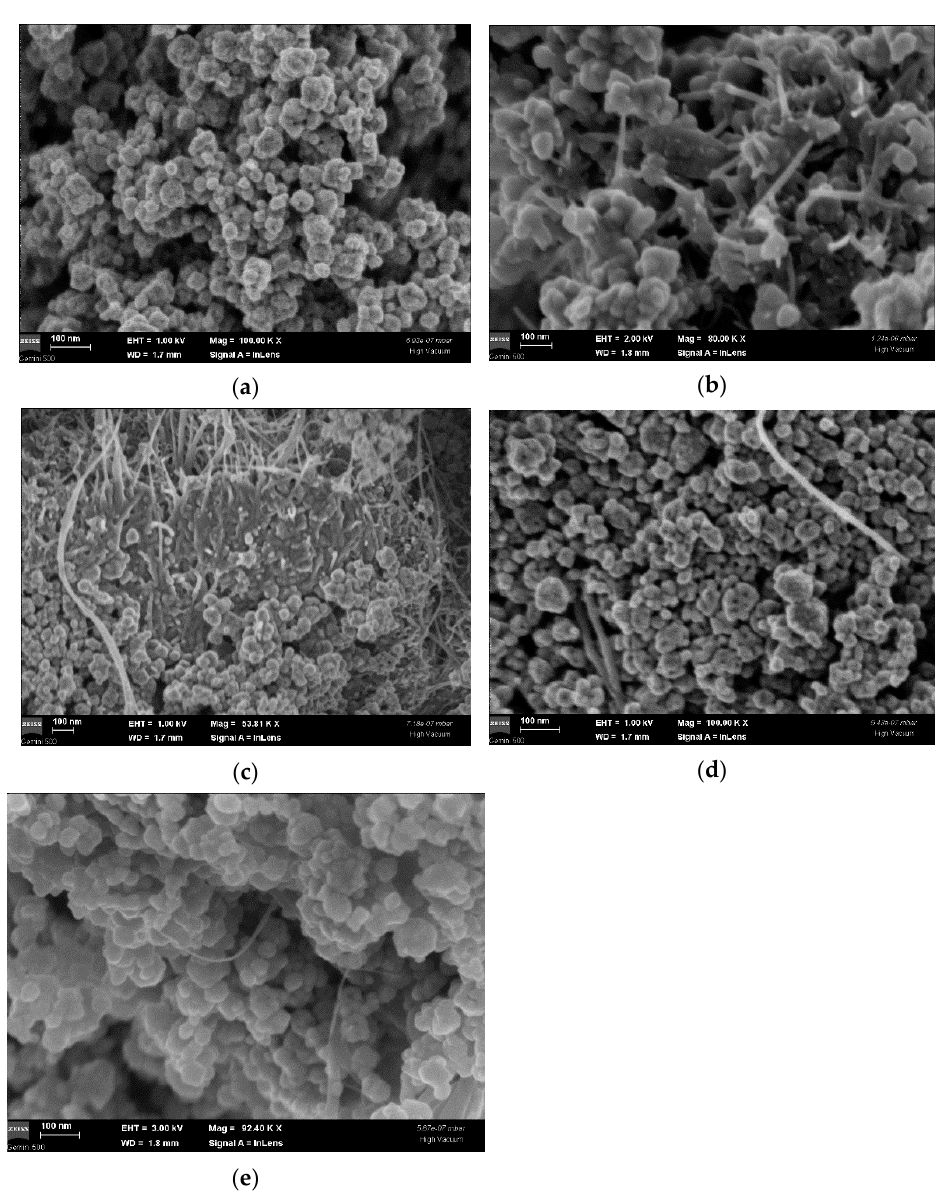
Figure 2. SEM images of the samples of TiO 2 :N ( a ); TiO 2 :N/SWNTs (S2 sample) ( b ); TiO 2 :N/DWNTs (D sample) ( c ); TiO 2 :N/MWNTs (M sample) ( d ); and TiO 2 :N/SWNTs-COOH (SC sample) ( e ).